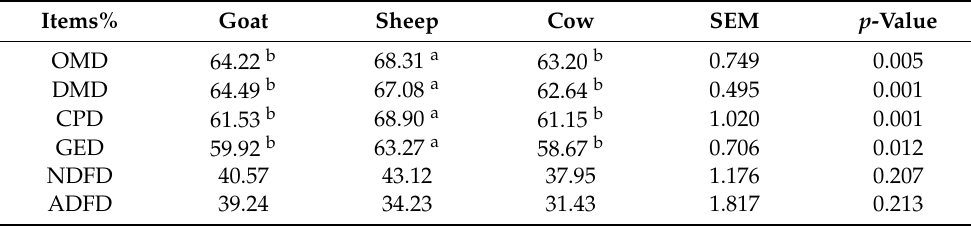
Table 3. Feed nutrient degradation of the goat, sheep, and cow. Items% Goat